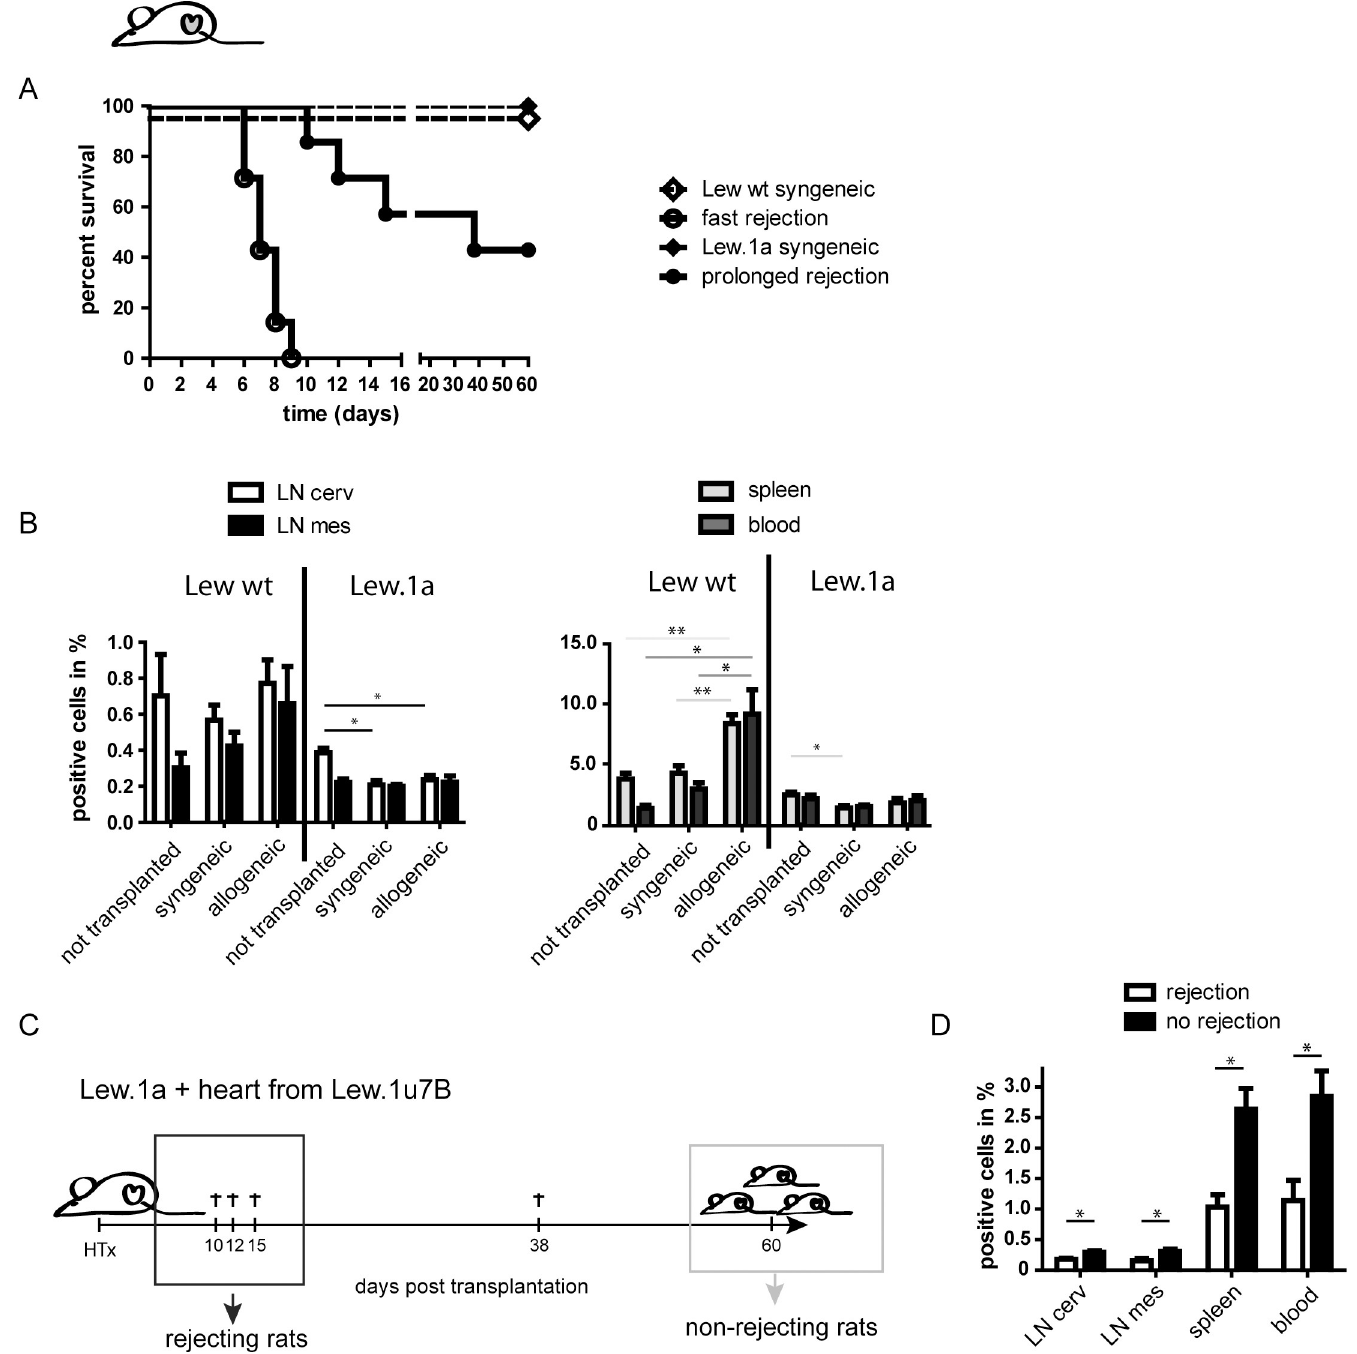
Fig 1. NK cells are affected differently by allogeneic grafts depending on the course of rejection. An illustration displaying a rat with a highlighted heart indicates that the presented data resulted from the model of HTx in distinction from data obtained from the second transplantation model, in which allogeneic heart muscle cells were injected into the ear of the respective recipients (see also Fig 3). (A) Perfused hearts derived from Lew.1a (RT1 a ) rats were heterotopically transplanted into the abdomen of Lew wt (RT1 l ) recipients (fast rejection) and Lew.1u7B (RT1 u ) hearts were engrafted in Lew.1a (RT1 a ) recipients (prolonged rejection). Syngeneic HTx served as a control group (n = 5). (B) Flow cytometric assessment of frequencies of NK cells in Lew wt and Lew.1a recipients after syngeneic and allogeneic HTx compared to na ï ve rats, respectively. The data implies divergent reactions of the two strains to the grafts: Upon allogeneic engraftment Lew wt recipients displayed increased NK cell ratios, which was observed especially in spleen and blood of the recipients, whereas Lew.1a recipients reacted with a general decrease of NK cell ratios compared to na ï ve rats or recipients of syngeneic grafts. (C) Three of 7 Lew.1a recipients receiving allogeneic grafts developed prolonged graft survival with no differences in viability, when compared to syngeneic controls over the complete observation period of 60 days resulting in the prolonged mean survival of allogeneic grafts in Lew.1a recipients. (D) NK cell frequencies of rejecting and non-rejecting Lew.1a recipients in cervical (cerv) and mesenterial (mes) LN, spleen and blood.